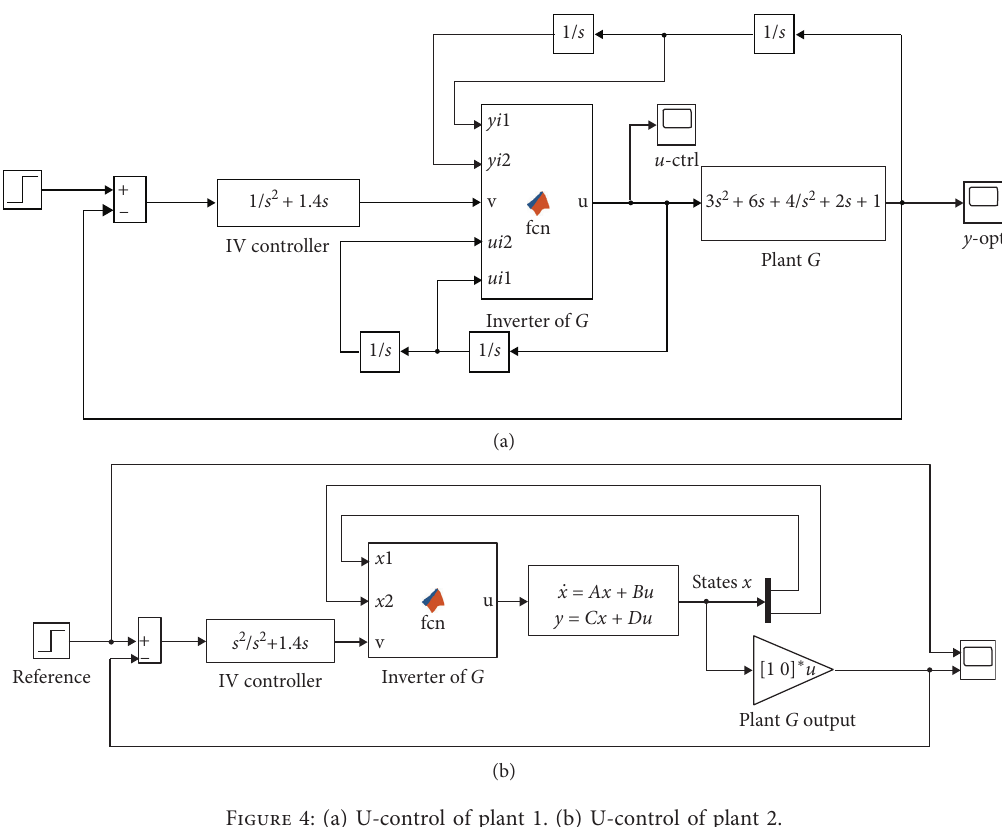
Figure 4: (a) U-control of plant 1. (b) U-control of plant 2.